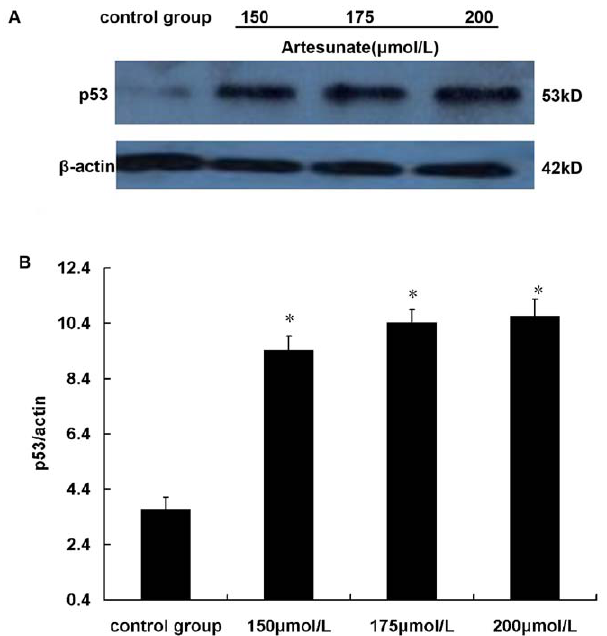
Figure 5. Effects of Artesunate on p53 contents in HSC (n=6). After HSCs acted by Artesunate 150 m mol/L, 175 m mol/L, 200 m mol/L, Compared with control group, the expression of p53 protein increased significantly in Artesunate group, * P , 0.05.